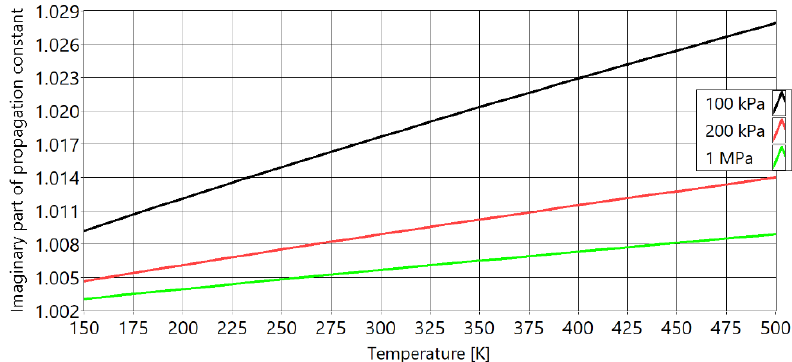
Figure 3. Imaginary part of the propagation constant of the full model for different values of pressure inside of PAT waveguide. With black is marked isobar of 100 kPa, with red is marked isobar of 400 kPa and with green is marked isobar of 1 MPa.